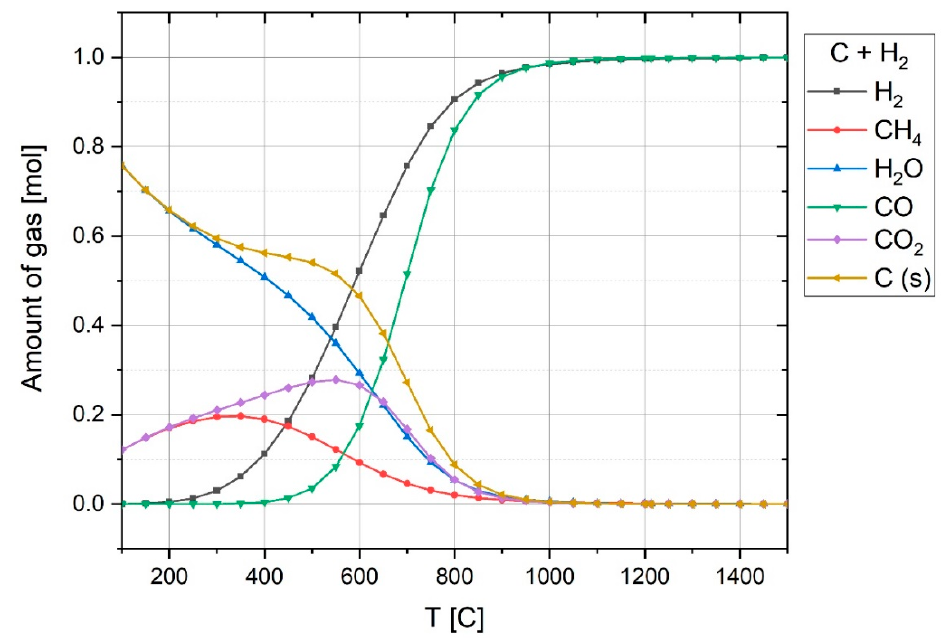
Figure 7. Composition of 1 mol C and 1 mol H 2 O at equilibrium at 1 atm pressure over temperature.